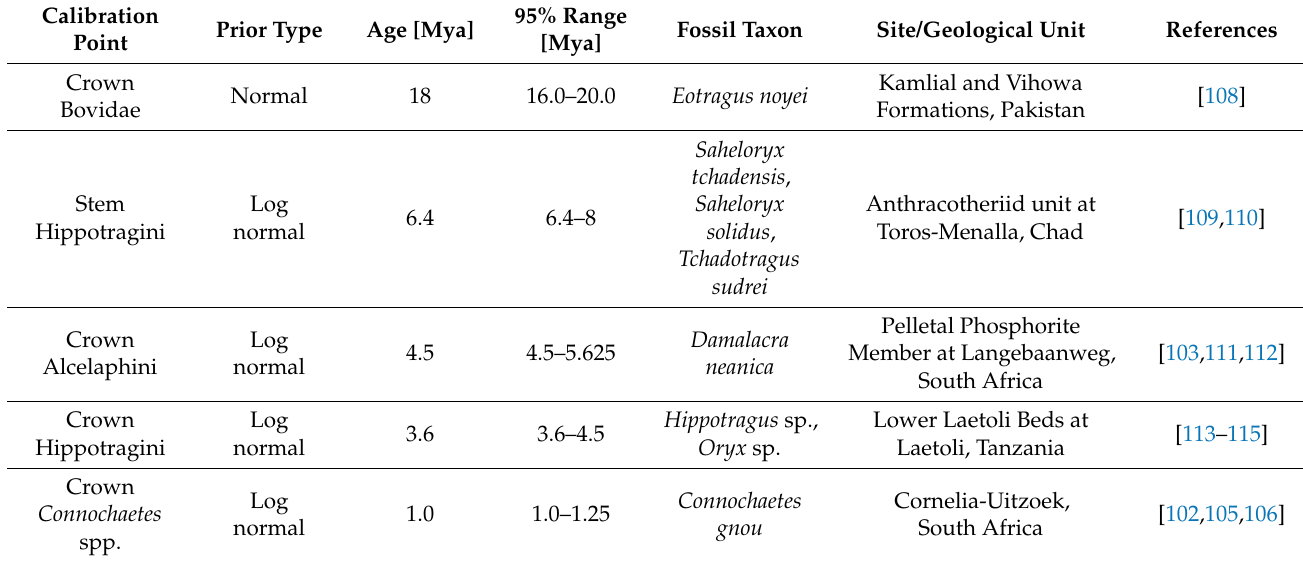
Table 2. Fossil calibration priors used with BEAUti/BEAST v2.5.0. Age and 95% ranges were determined as 1.25 × the minimum age (lognormal prior) or ± 25% of an approximate age (normal prior). The crown bovid node is calibrated using a normal prior as E . noyei is presumed to be closely related to crown bovids but its exact relationships to the crown clade remain